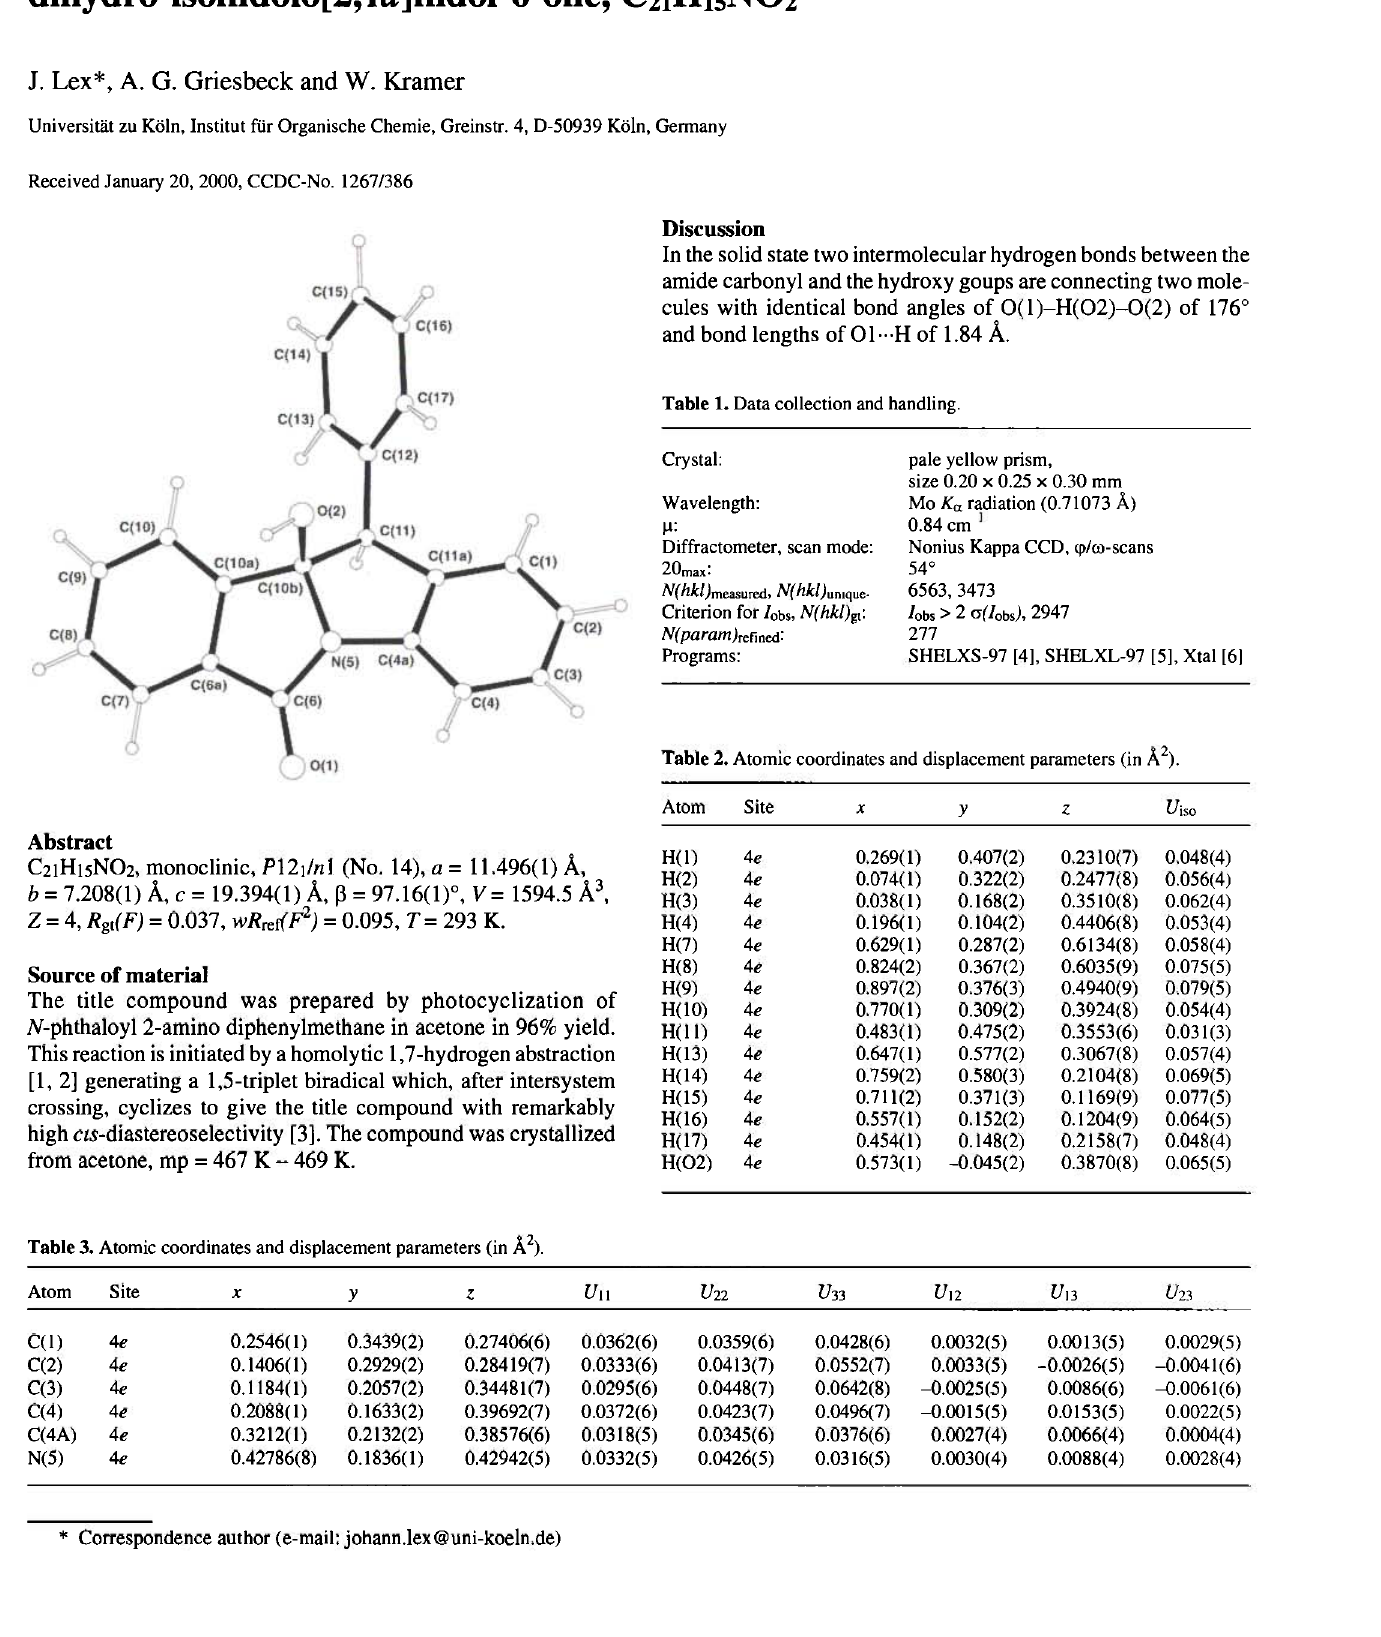
Table 1. Data collection and handling. Crystal: